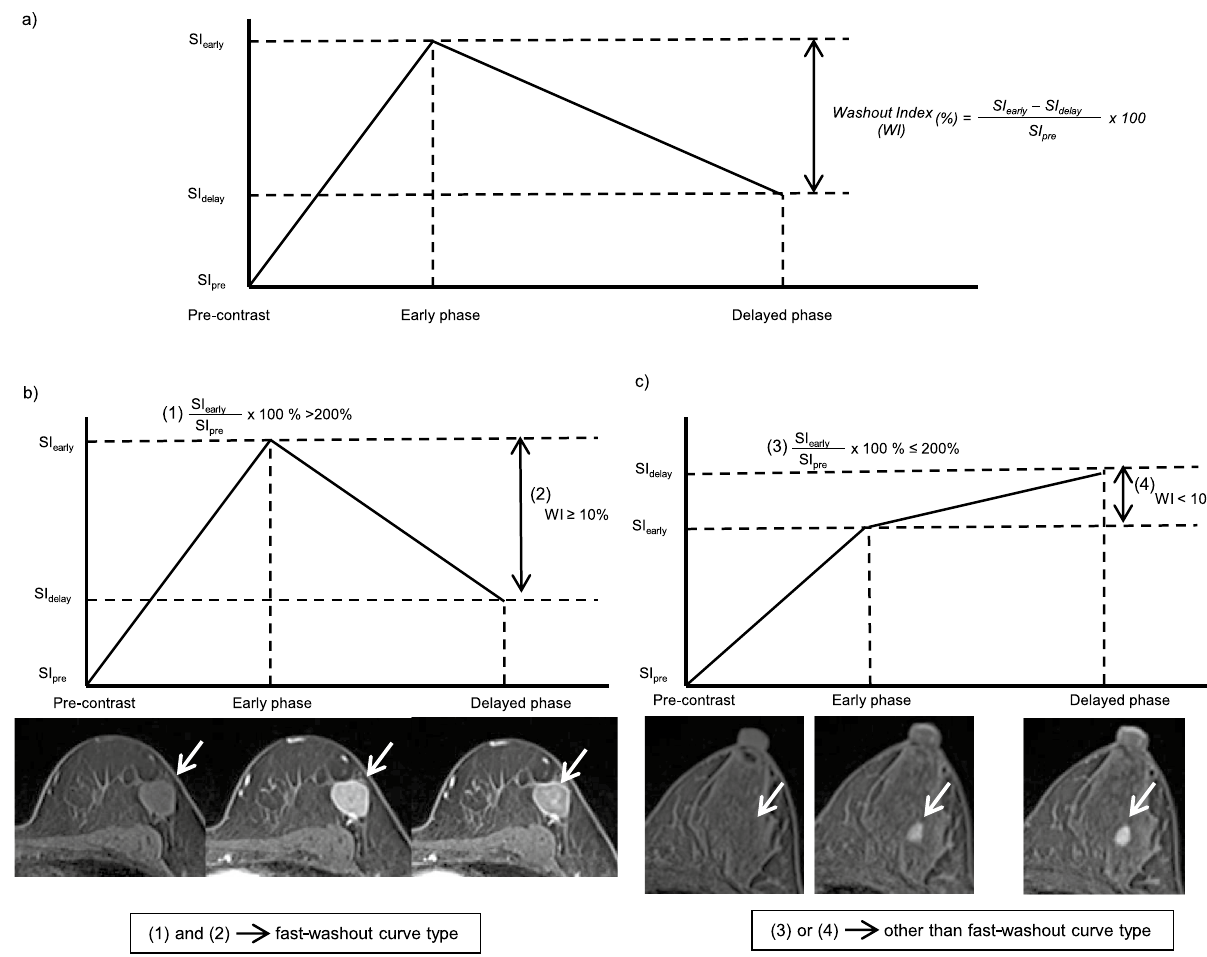
Figure 1. Image analysis of DCE-MRI; Signal intensity (SI), washout index (WI) and curve type of a lesion. A circular region of interest (ROI) of 3 × 3 mm was placed inside a lesion to identify the highest value of WI ( a ). WI was calculated from the three SIs of the same ROI on each phase (pre-contrast [SI pre ], early phase [SI early ] and delayed phase [SI delay ]): WI = (SI early − SI delay )/SI pre × 100%. If SI early /SI pre × 100% > 200% and WI ≥ 10%, the lesion was classified as “fast-washout curve type” ( b ). On the other hand, SI early /SI pre × 100% ≤ 200% or WI > 10%, the legion was classified as other than “fast-washout curve type” ( c